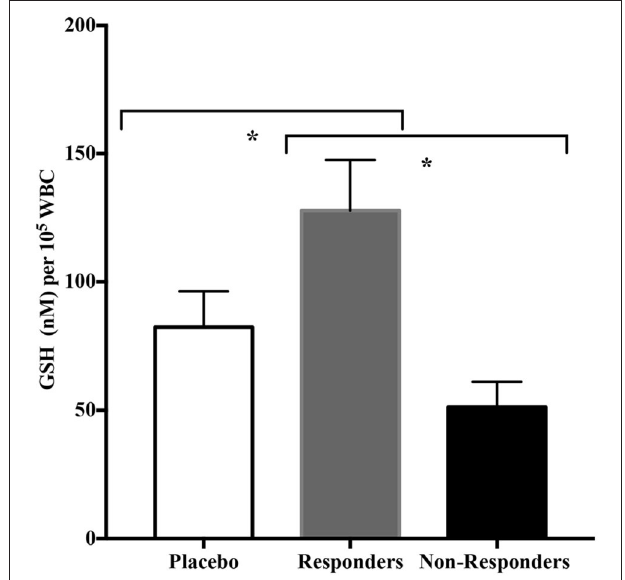
FIGURE 4 | Baseline glutathione levels in placebo, responder and non-responder groups. * p < 0.05.